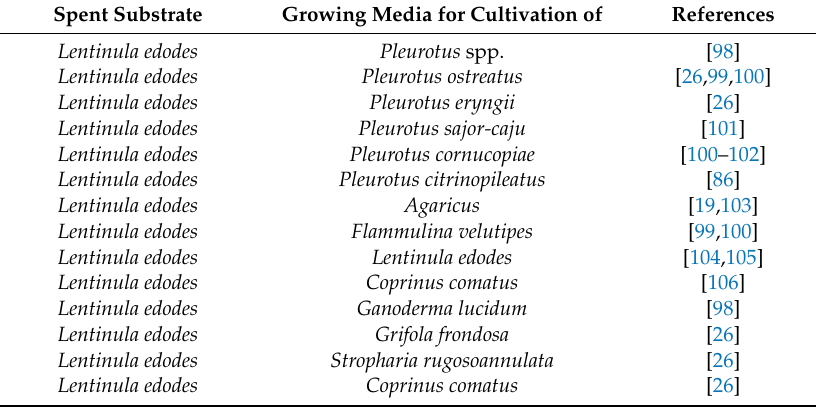
Table 4. Reuse of SMS of Lentinula edodes in new substrate formulations. Spent Substrate Growing Media for Cultivation